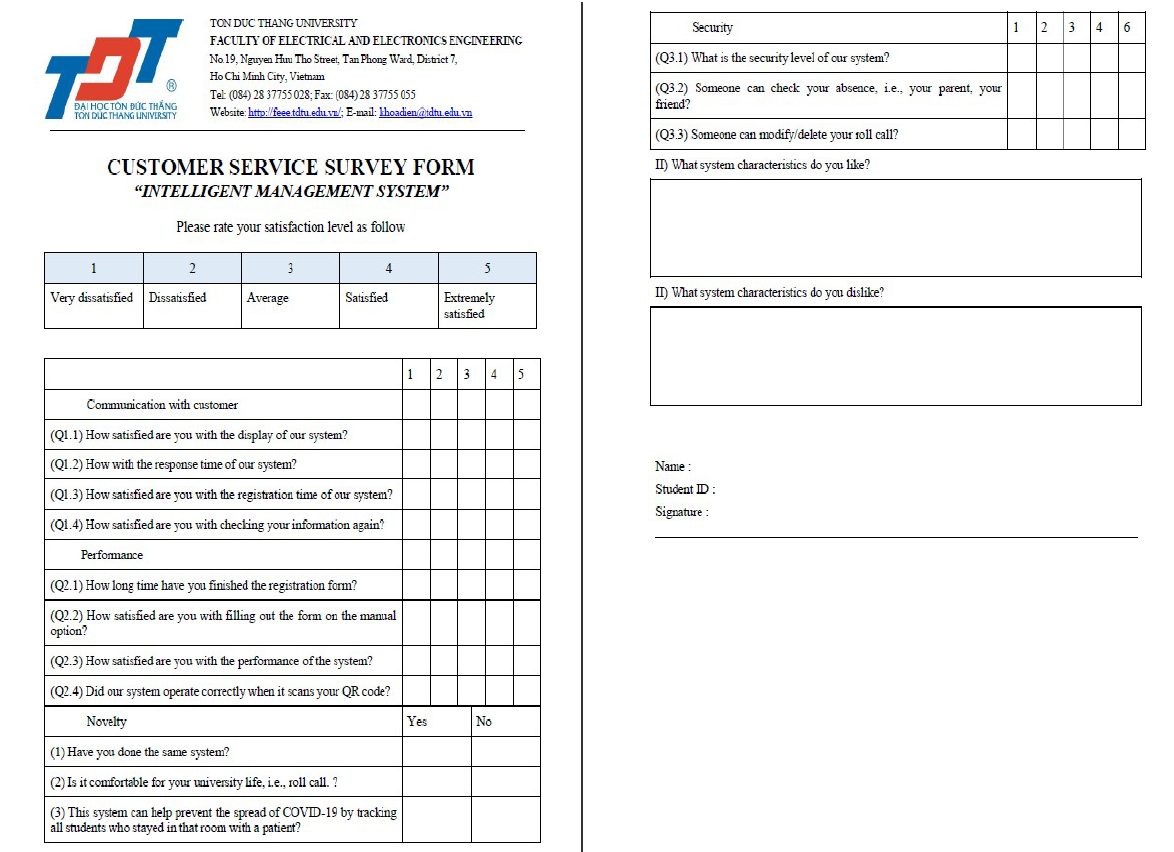
Figure 18. Customer service survey form.